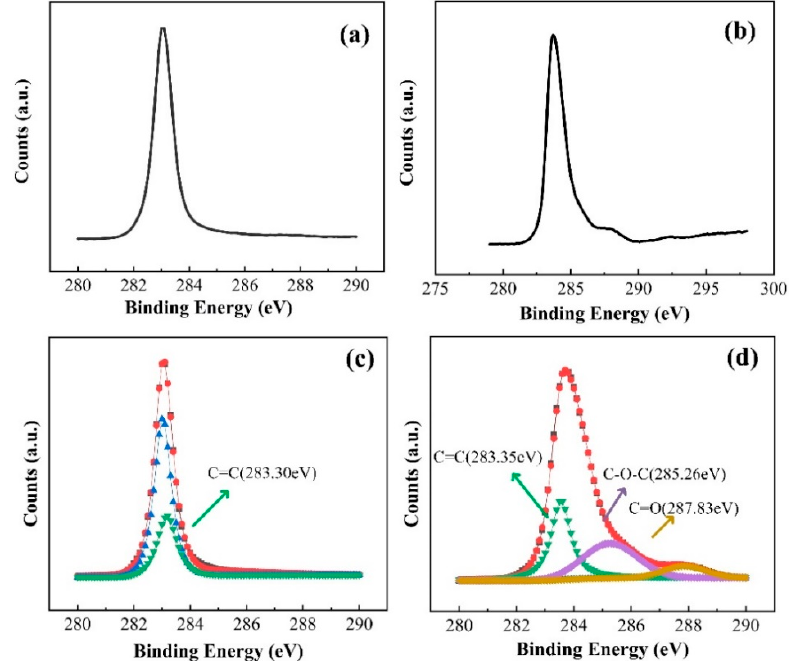
Figure 4. The survey and resolution spectra of C1s. Comparison between before ( a ) and after ( b ) reaction for high-resolution spectra of the C1s. Simulation of XPS spectrum toward surface on diamond before ( c ) and after ( d ) photocatalyst. Carbon–oxygen bonds appeared on the surface after catalysis.